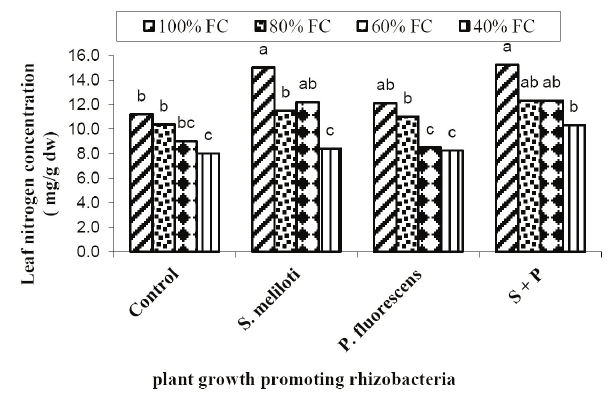
fig. 5 - Interaction of PGPR and soil water content on N concen- tration of fenugreek shoot.